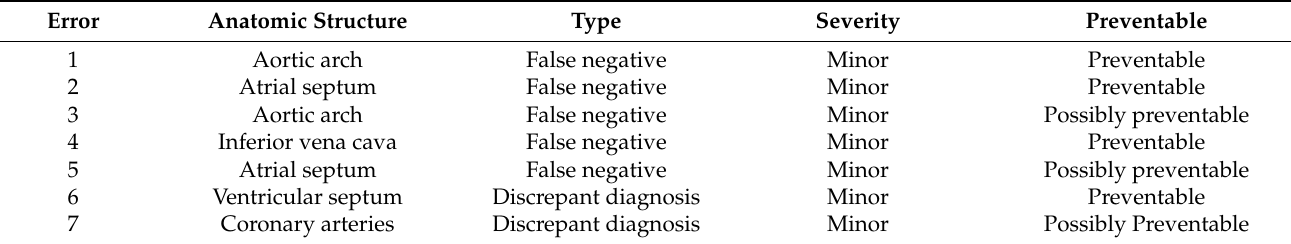
Table 2. Diagnostic errors identified in the follow up